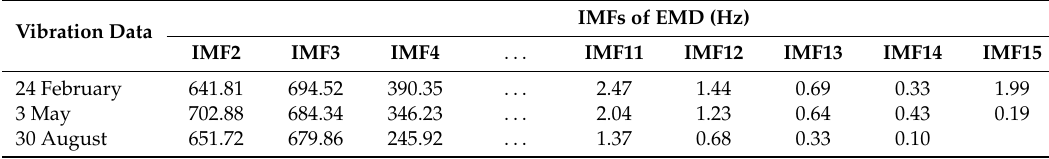
Table 3. Decomposition result of EMD method for the slew bearing data.